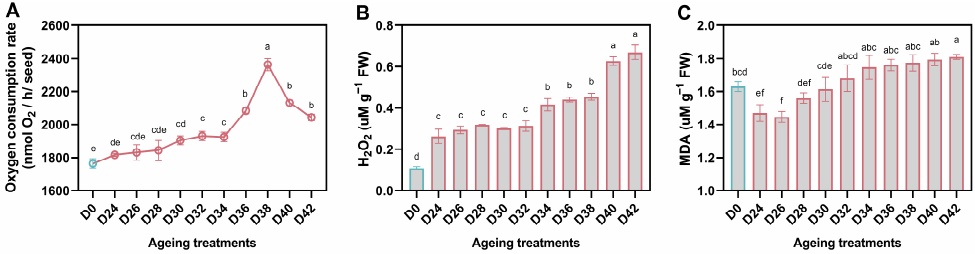
Figure 4. Influence of aging treatment on the oxygen consumption rate ( A ), H 2 O 2 accumulation ( B ) and MDA content ( C ) of oat seeds. The letters represent statistical significance among the treatments and the vertical bars represent the ± SEM at p < 0.05 level for three replicates. The mean values sharing same letters, obtained from Duncan test, are not different significantly.